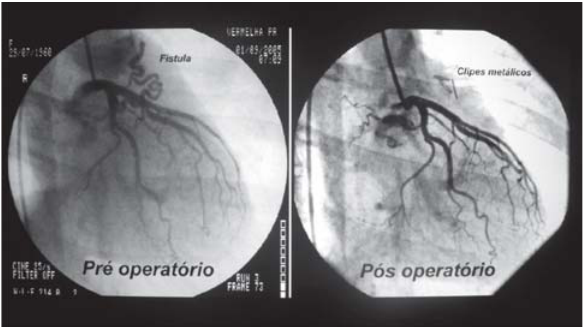
Fig. 2 - Coronariografia pré e pós-operatória da fistula coronário- pulmonar. A: envolvendo artéria coronária descendente anterior e artéria pulmonar; B: resultado após a clipagem da